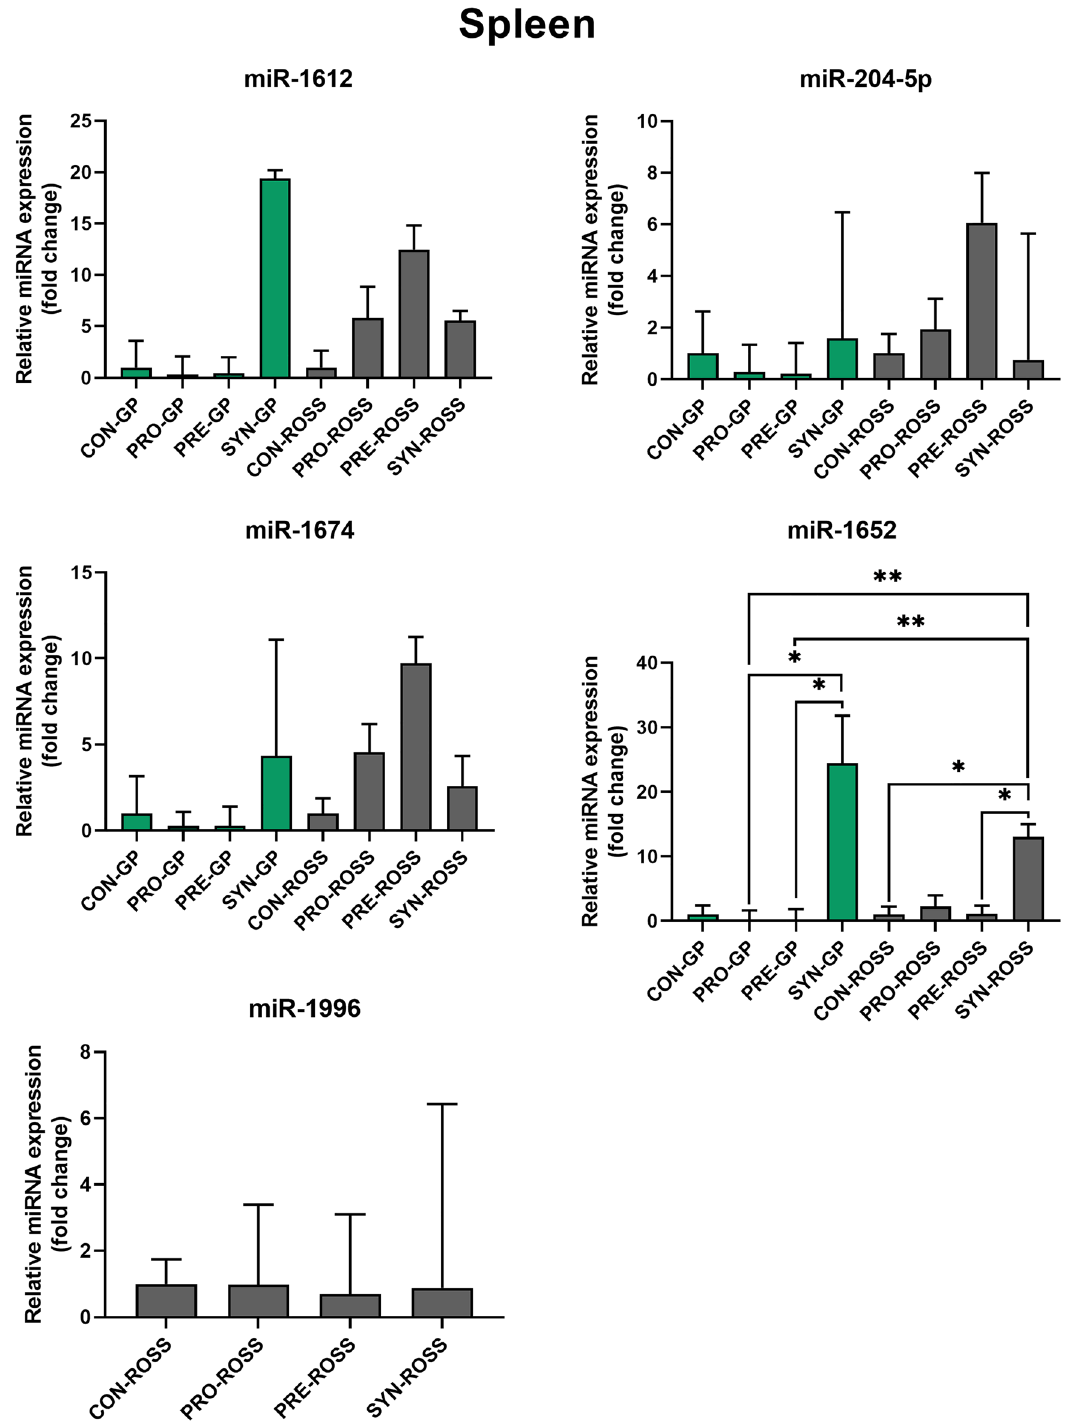
Figure 1. The Relative microRNA (miR) expression in the spleen of Green-legged partridgelike chickens (GP) and ROSS 308 broilers (ROSS) injected in ovo with saline-CON, probiotic-PRO, prebiotic-PRE, and synbiotic-